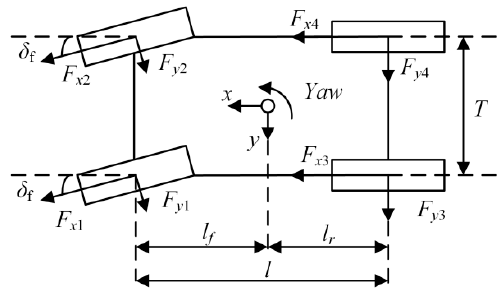
Figure 2. Vehicle dynamics model.